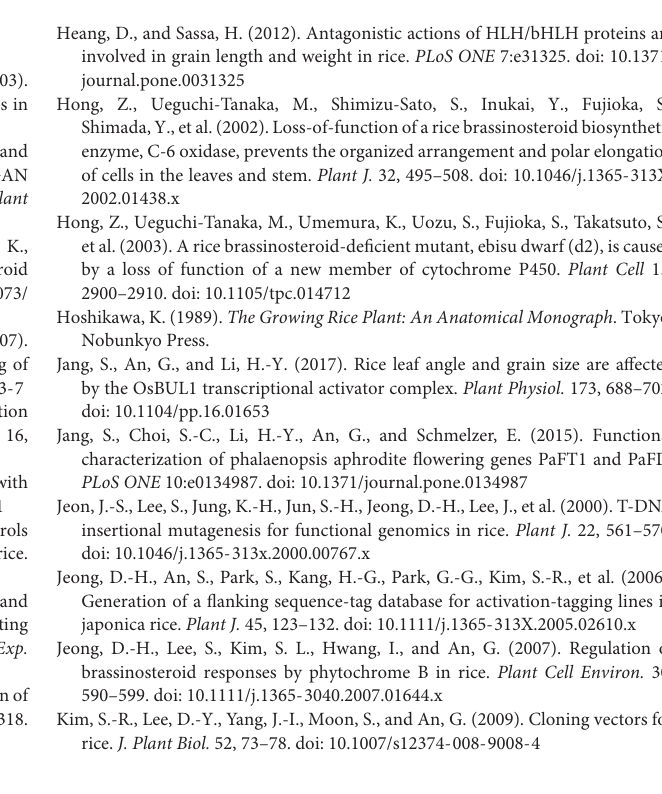
transgenic lines also show a significant increase. (mm; n > 25). ( ∗ P < 0.01, Student’s t- test). FIGURE S4 | Expression pattern of OsBDG1 , OsAP2.2 and OsWRKY24 analyzed by quantitative RT-PCR and lamina inclination of p OsBUL1 : OsBDG1 and OsBDG1 -dsRNAi plants in lamina bending assays. (A) Spatiotemporal expression patterns of genes studied. Error bars indicate SD of three technical repeats. (B) Expression analyses of genes with treatment of GA3 and BL at 24 h time points after treatment. Data are the average of three or four independent experiments and normalized by OsUBQ or OsAct . Error bars indicate SD of three biological replicates. Differences between the mock and hormone treated samples are highlighted with ∗ P < 0.01; ∗∗ P < 0.05 with Student’s t- test. (C) Lamina joint inclination bioassays with various concentrations of BL. FIGURE S5 | Subcellular localization of proteins. (A) YFP:OsBDG1 and CFP:OsBC1 were co-transformed into rice protoplasts. OsBDG1 is localized in the cytoplasm as well as the nucleus while OsBC1 (Jang et al., 2017) is only found in the nucleus. (B) CFP:OsBDG1 and YFP:OsBUL1 were co-transformed into rice protoplasts. OsBDG1 and OsBUL1 are co-localized in the cell. (C,D) CFP:OsAP2.2 and CFP:OsWRKY24 are localized in the nucleus. Bar = 5 µ m. FIGURE S6 | Morphological alteration of epidermal cells of lemma from p OsBUL1 : OsAP2.2 and p OsBUL1 : OsWRKY24 and expression pattern of genes involved in cell elongation. (A) Elongated epidermal cells of lemma from p OsBUL1 : OsAP2.2 and p OsBUL1 : OsWRKY24 transgenic plants compared to those of WT. Bar = 100 µ m. (B) Expression of genes involved in cell elongation in spikelets of transgenic lines. Data are the average of three independent experiments and normalized by OsAct . Error bars indicate SD. (C) Transcriptional activation activity analyses of OsAP2.2 and OsWRKY24. Unlike BD-OsBDG1, both BD-OsAP2.2 and BD-OsWARK24 fusion proteins displayed a transcriptional activation activity in the yeast system described by Jang et al. (2015). TABLE S1 | Primers used for expression analyses in this